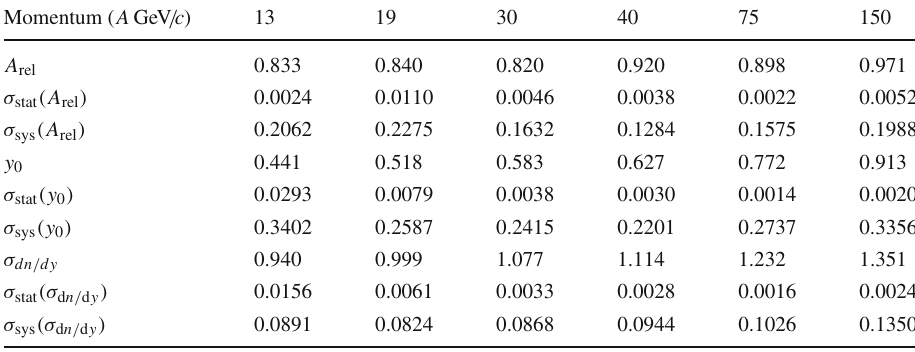
Table 3 Parameters A rel , y 0 of the double Gaussian fit